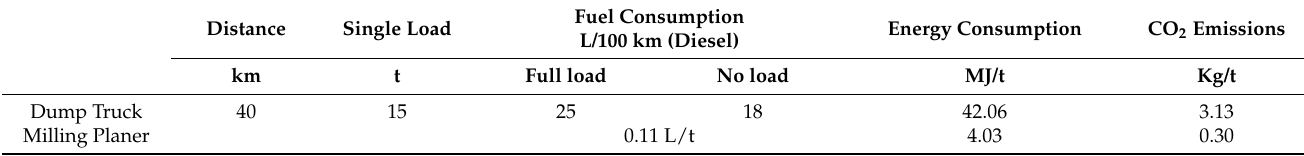
Table 8. Energy consumption and greenhouse gas emission inventory in the structural demolition stage.